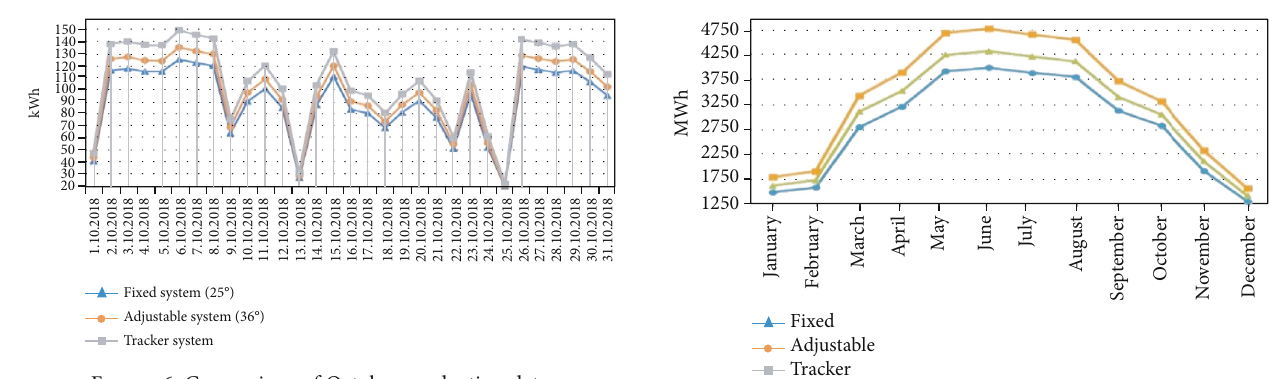
Figure 7: Graph of comparison of solar-tracking system applications according to monthly production